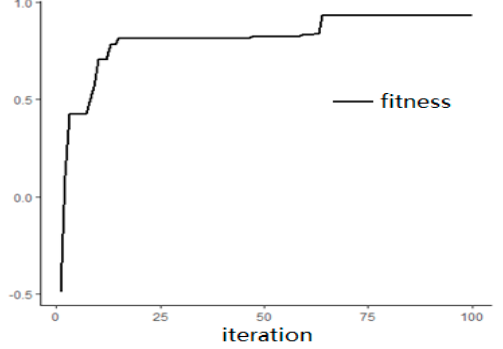
Figure 2. The run results.